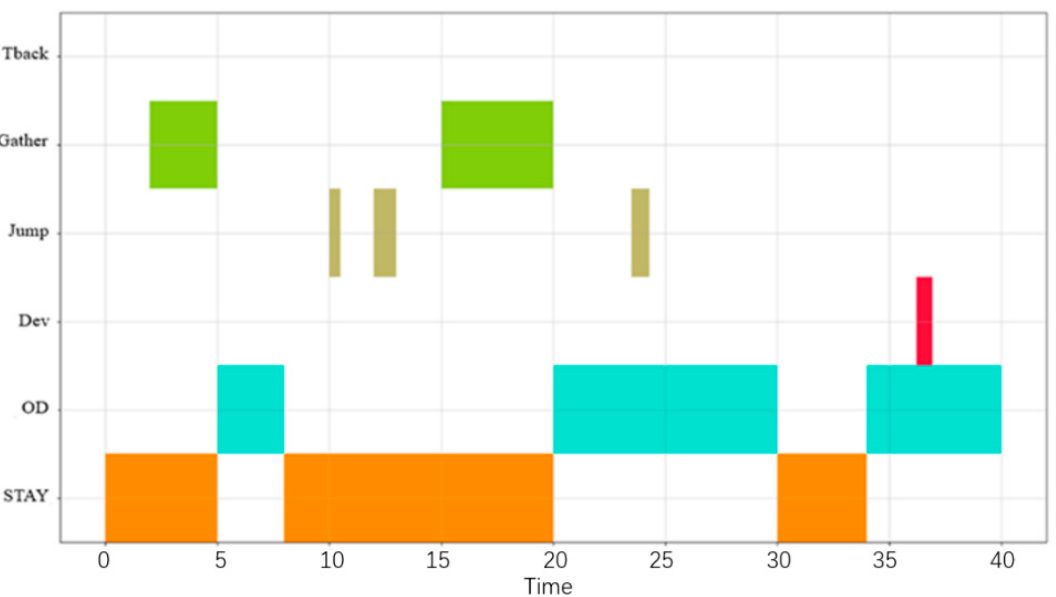
Figure 8. Visualization of a ship CSBP .